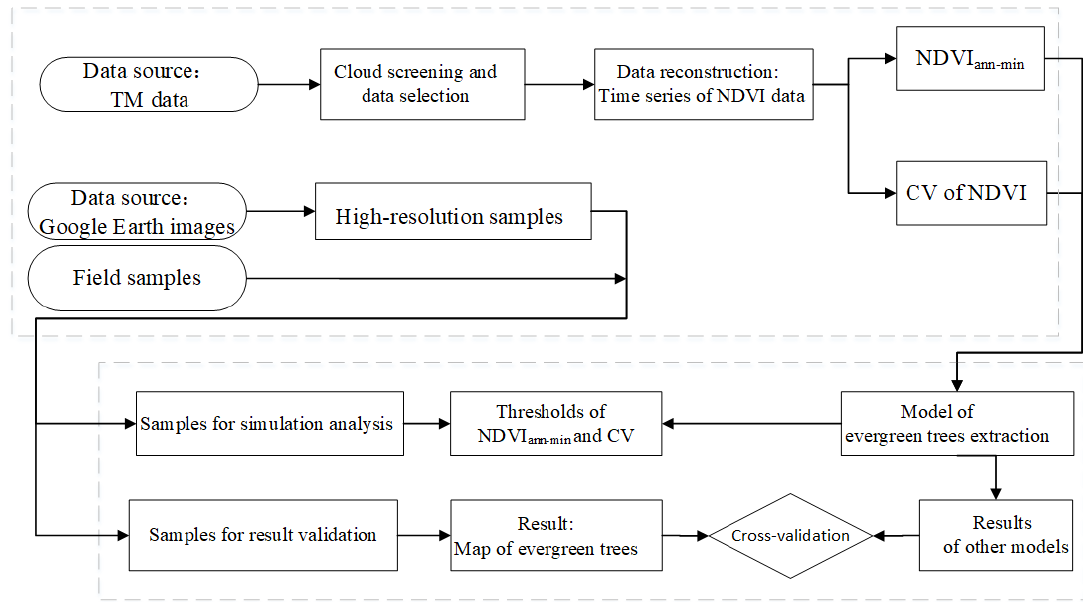
Figure 2. Flowchart of subtropical evergreen tree mapping and accuracy assessment. TM = Thematic Mapper; NDVI = normalized difference vegetation index; CV = coefficient of variation.